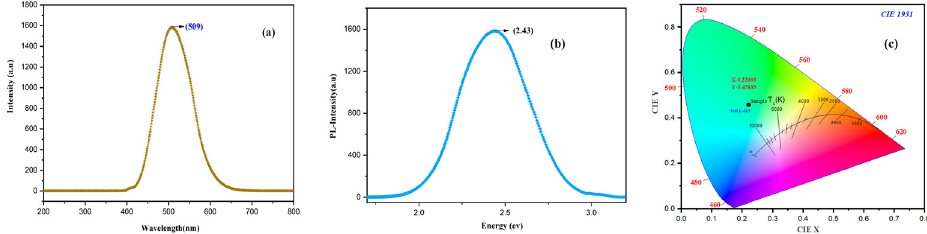
Figure 10. ( a ) PL spectrum of MMPI crystal ( b ) band gap of MMPI and ( c ) CIE chromaticity plot of MMPI.